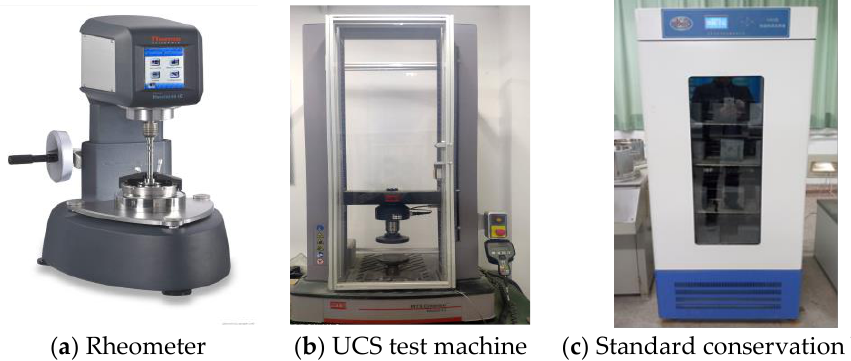
Figure 3. Experimental equipment.